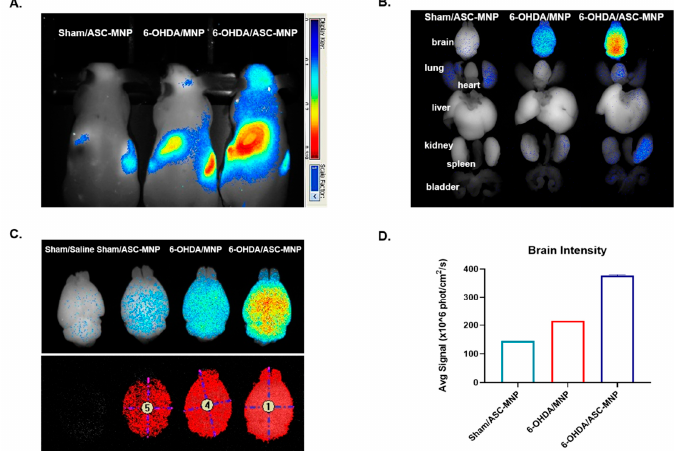
Figure 3. Maestro imaging was performed in hASCs injected mouse (Saline/ASC-MNP), magnetic nanoparticles-labeled